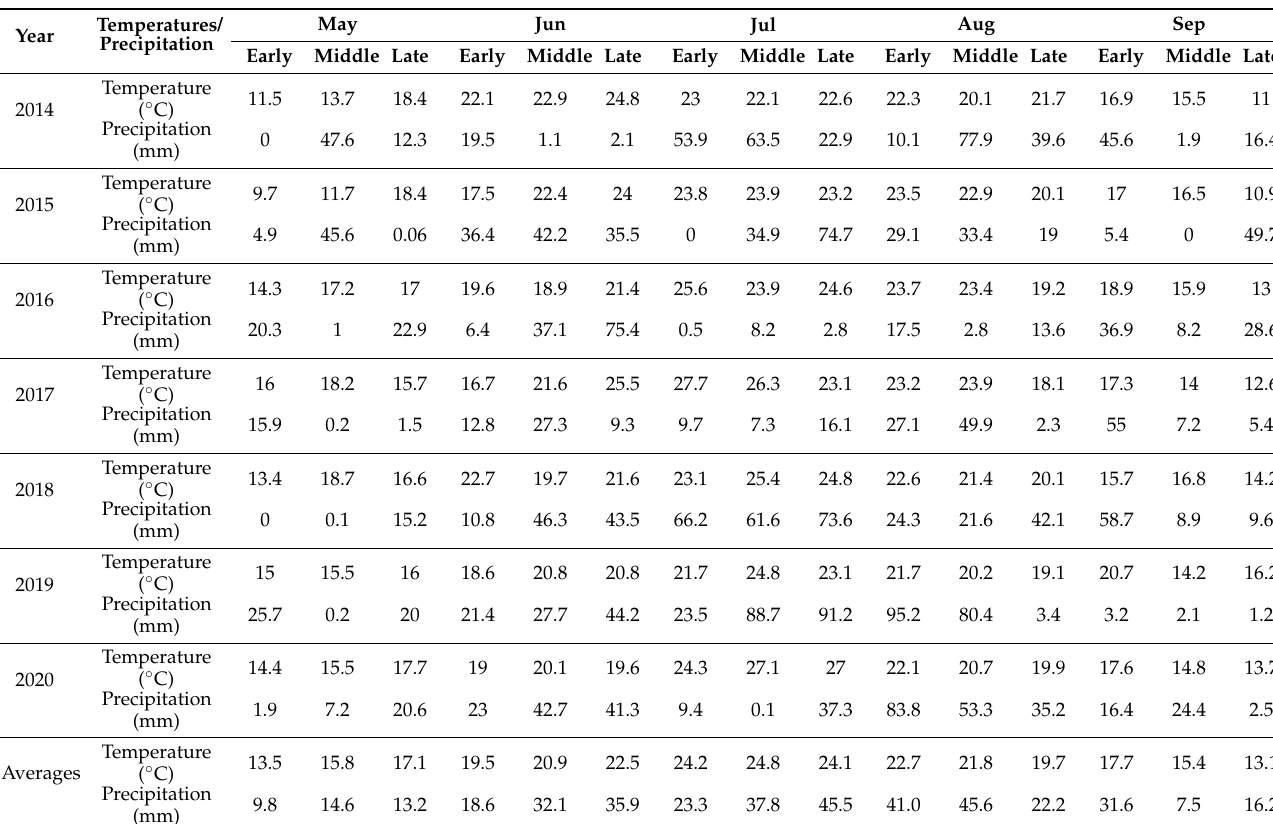
Table 1. Meteorological parameters for the experimental site (Qiqihar, Heilongjiang